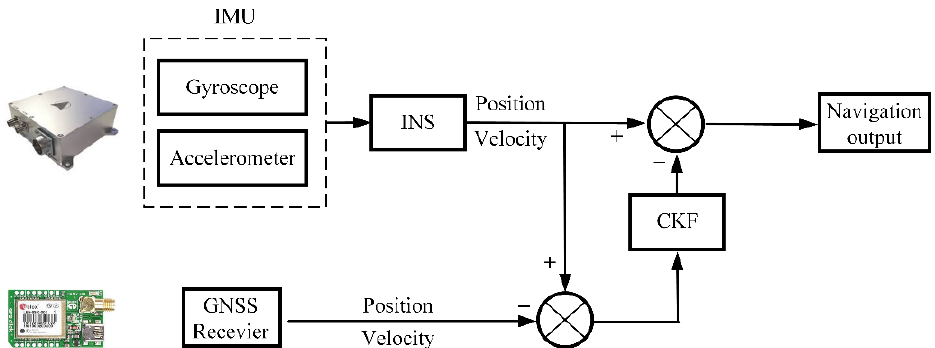
Figure 1. Flowchart of the loosely coupled integrated system.